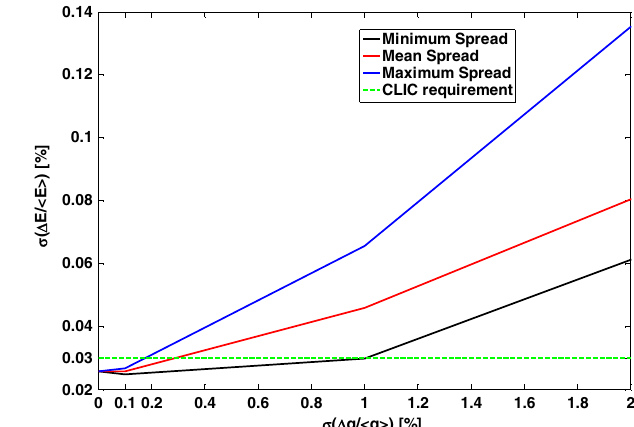
FIG. 24. Effect of influence of the drive beam charge jitter on the energy